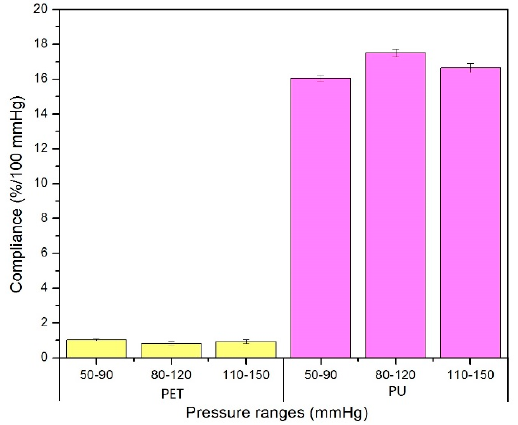
Figure 10. Compliance of ( a ) PET and ( b ) PU grafts under three pressure ranges.